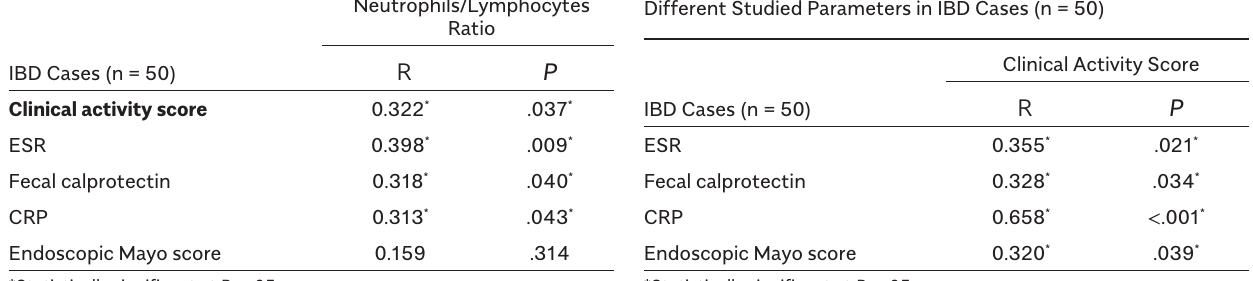
Table 3. Correlation Between Clinical Activity Score with Different Studied Parameters in IBD Cases (n =